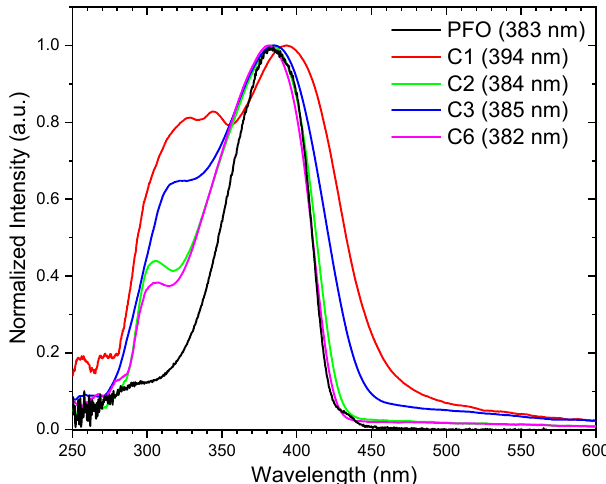
Figure 4. Normalized absorbance of C1, C2, C3, and C6 as compared to a PFO film (black). The maximum absorption wavelengths for each polymer are given in brackets.